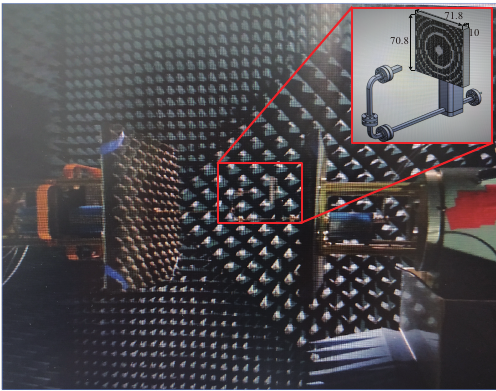
Figure 7. A picture of the reflectarray antenna measurement configuration and the three-dimensional modeling of the designed antenna and a